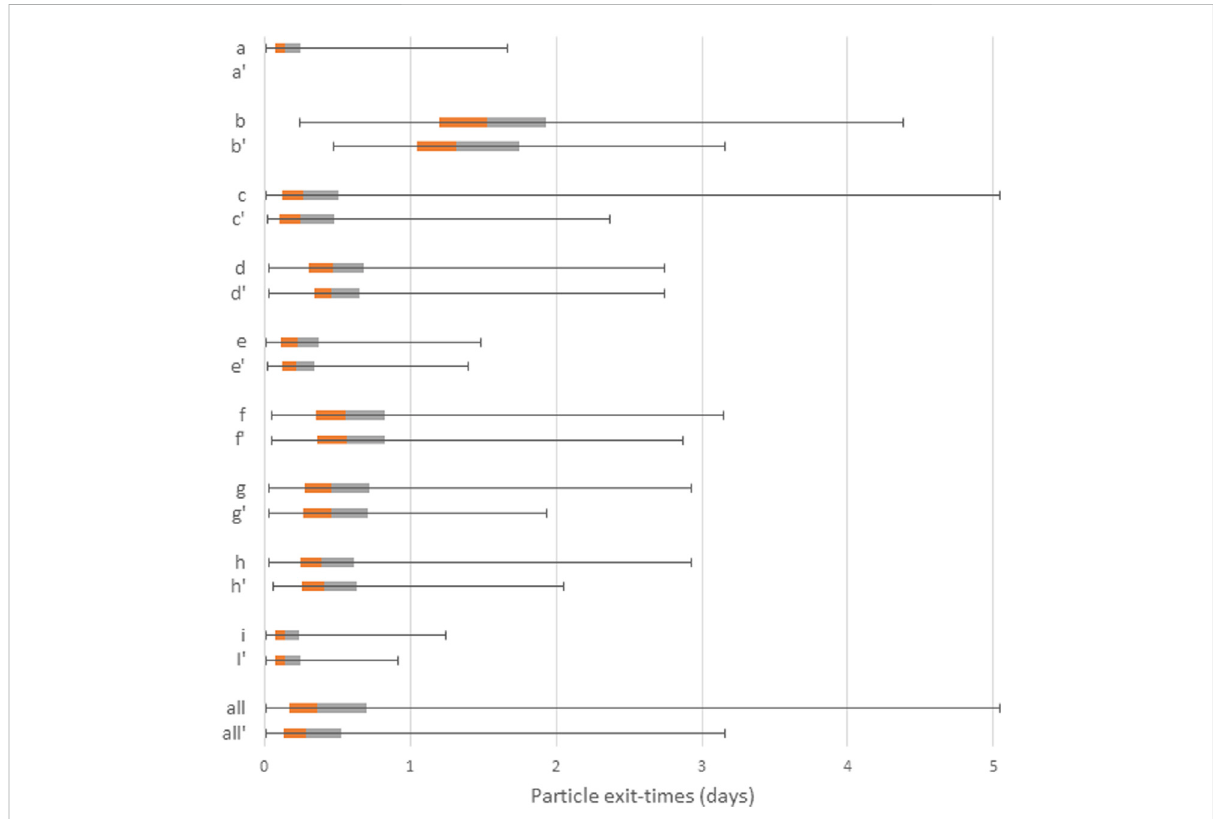
FIGURE 8 Boxandwhiskerplotsshowingrelativeparticleexit-timesforTPmodels (a – i) togetherwiththeircombinedtimes(all).The ‘ suf fi xrepresentsthe exit-times derived from the plausible realizations for each TP model. Box and whiskers represent the minimum, maximum and lower and upper quartile of the particle